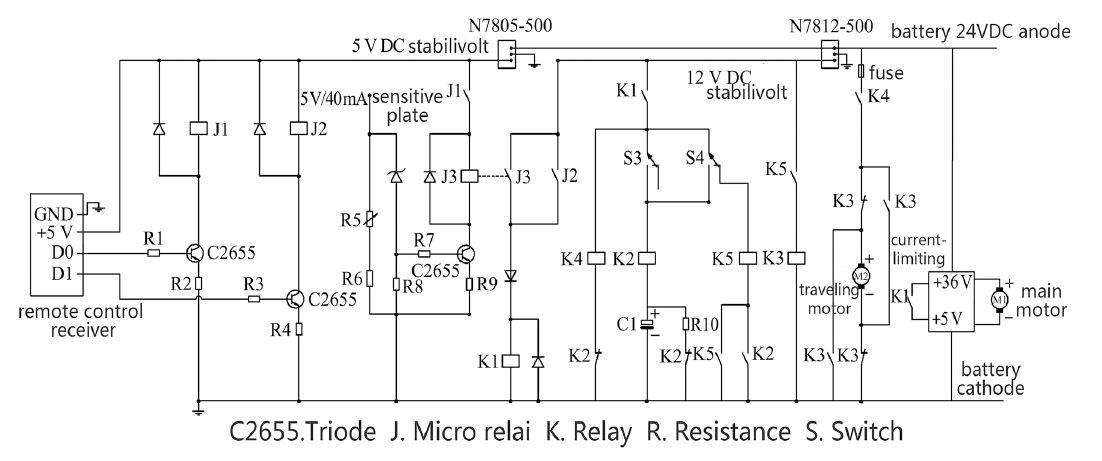
Fig 5. Sketch map of the working control system of the